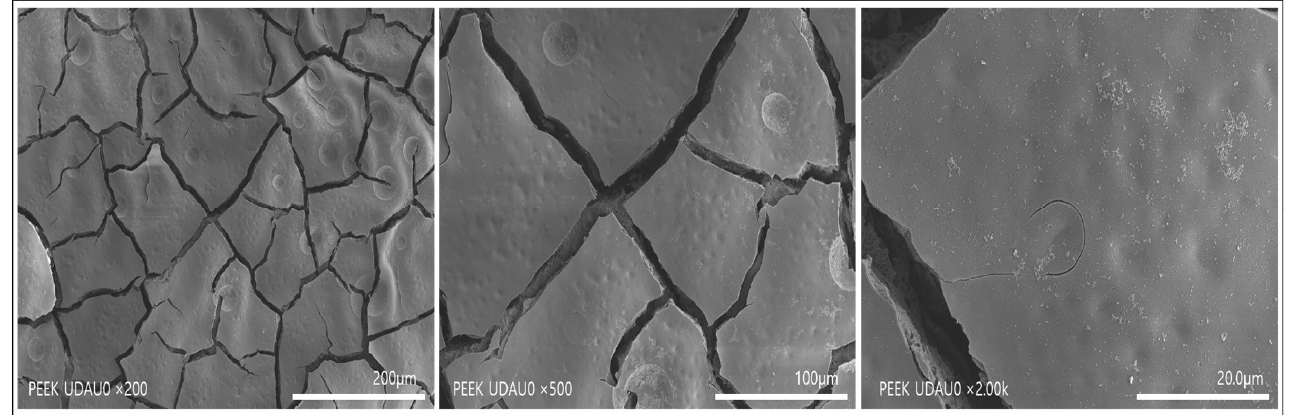
Figure 2. SEM images of PEEK implants treated with a mixed acid of sulfuric and nitric acid for 90 s under ultrasound and then washed with distilled water under mechanical agitation for 6 h.